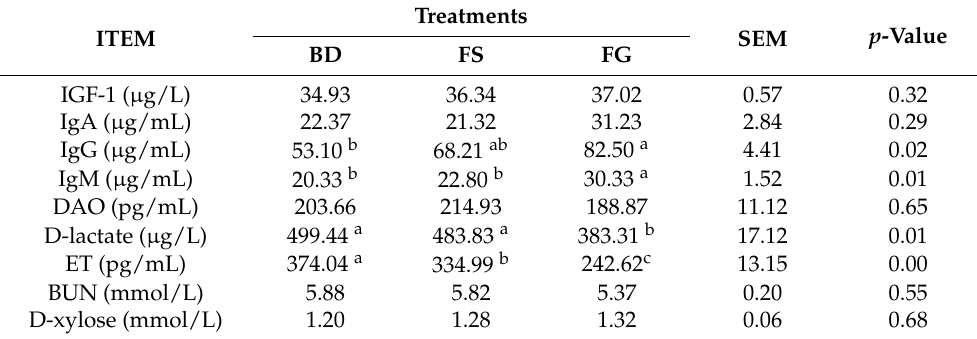
Table 3. Effect of different iron sources on serum parameters in weaned pigs.